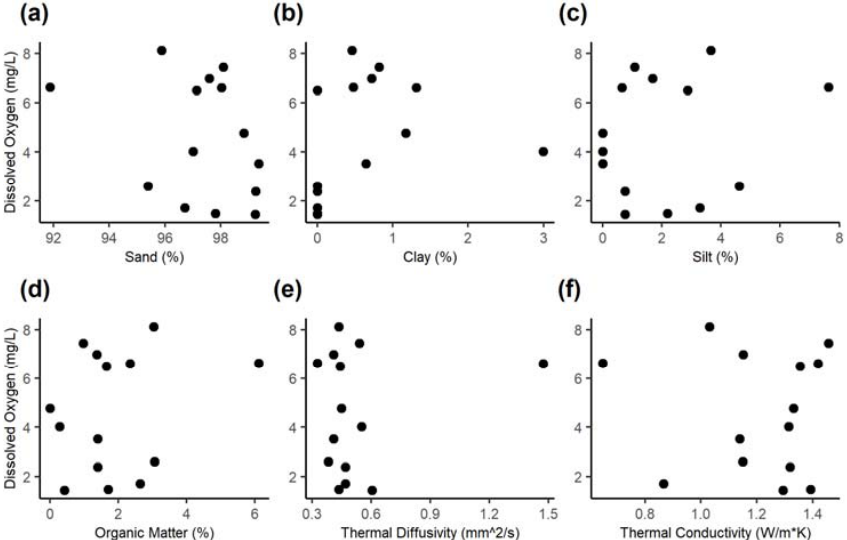
Figure 4. Dissolved oxygen measured in groundwater discharge compared to ( a ) % sand, ( b ) % clay, ( c ) % silt, ( d ) % organic matter, ( e ) thermal diffusivity, and ( f ) thermal conductivity measured in the local surficial soil sample for a subset of PDPs ( n = 14) in the Farmington River study reach.